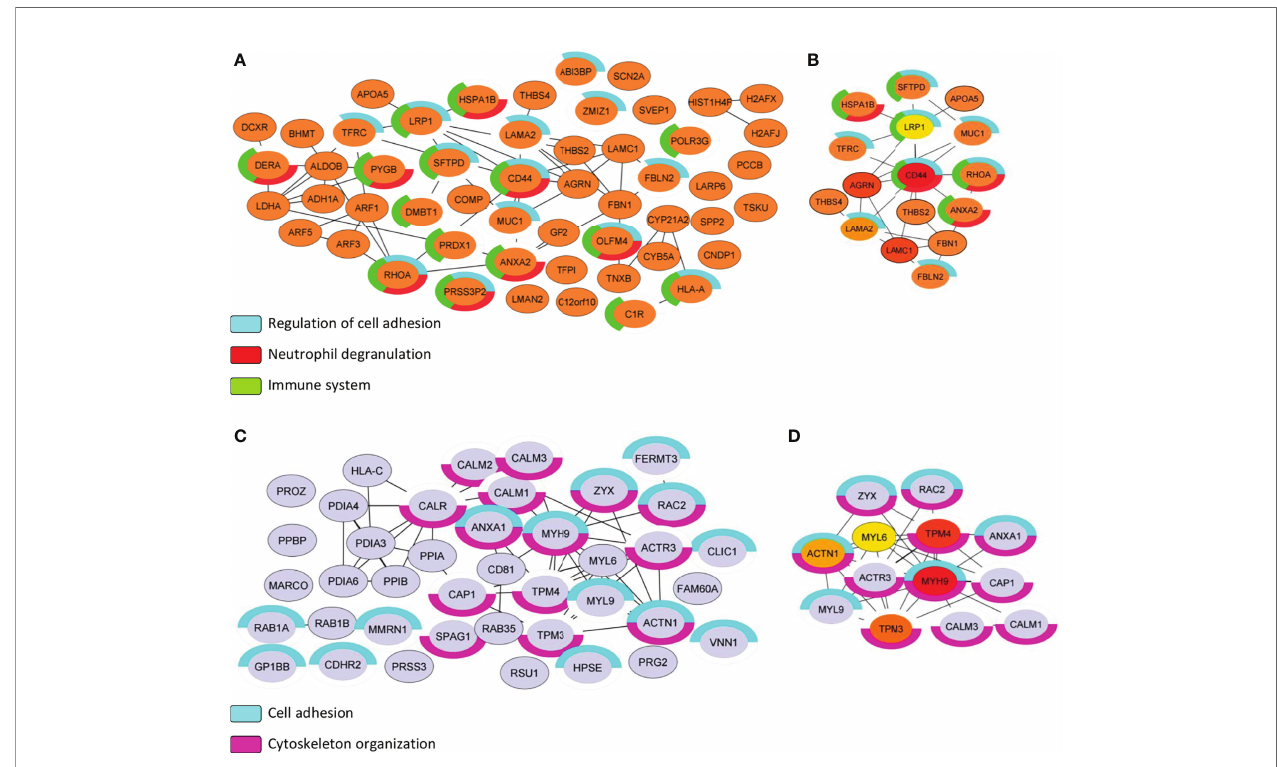
FIGURE 9 | Subnetwork analysis of S vs NS EVs proteome. (A, C) Protein – protein interaction analysis was performed with the STRING database on Cytoscape program. Only physical interactions in STRING (physical score >0.132) were considered. For each protein list (S vs NS), functional analysis with human genome reference was applied, and terms associated with the immune system biological process were highlighted by color charts. (B, D) Maximal Clique Centrality (MCC) is used to discover featured nodes in the subnetwork, used through CytoHubba application. The analysis returned the top 5 central nodes of NS proteome: CD44 antigen (CD44), Agrin (AGRN), Lamin subunit gamma-1 (LAMC1), Lamin subunit gamma-2 (LAMA2), and Prolow-density lipoprotein receptor-related protein 1 (LRP1). While the top 5 central nodes of S proteome were: Myosin-9 (MYH9), Tropomyosin alpha-4 chain (TPM4), Tropomyosin alpha-3 chain (TPM3),